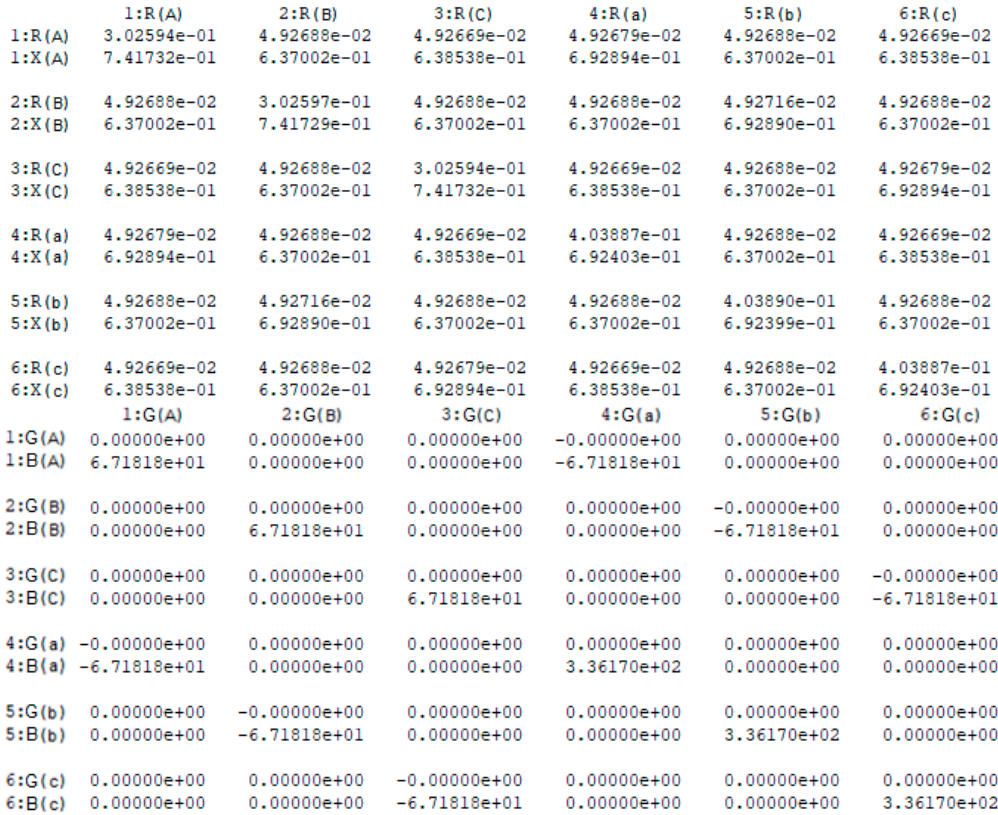
Figure 10. Current in the middle cable with additional resistance; formation presented in Figure